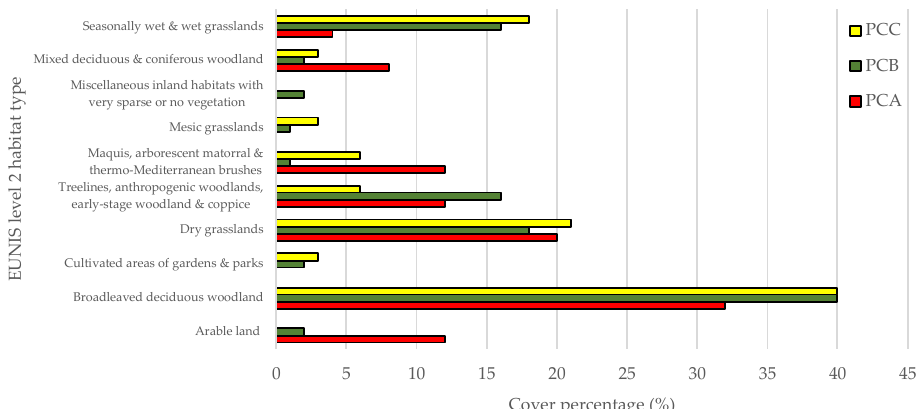
Figure 3. Collected plant taxa (species and subspecies) per priority category (PCA: Threatened and Near Threatened, PCB: Local Balkan endemics and subendemics, PCC: Regionally rare and/or uncommon plants) and level 2 EUNIS habitat type.